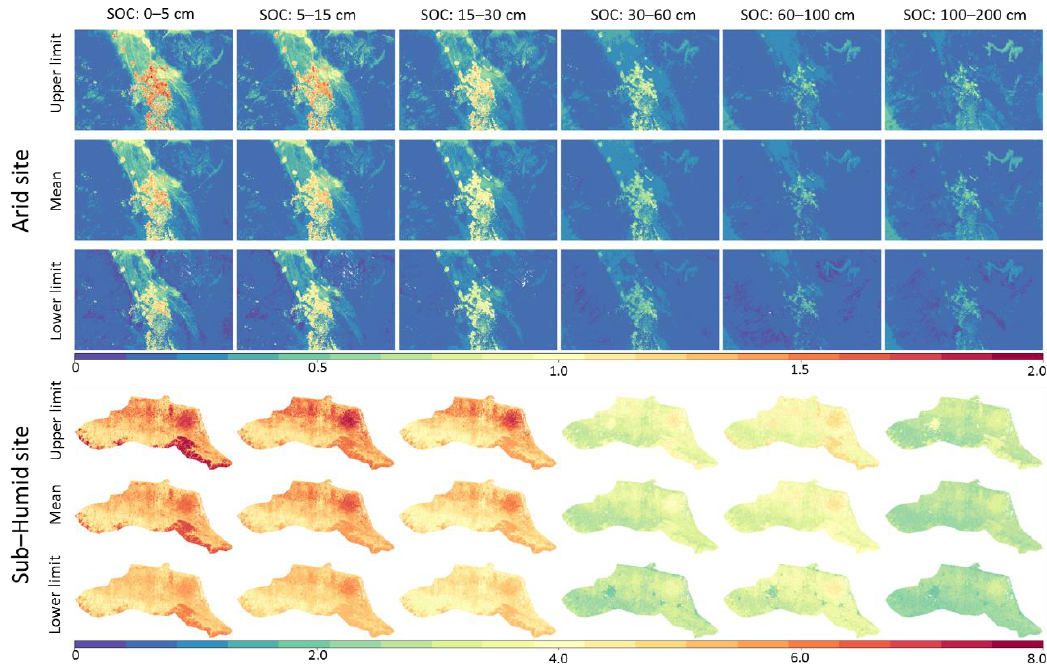
Figure 8. The spatial distribution of mean, upper, and lower limits of SOC contents at six standard depths in two regions. The upper and lower limits were calculated using Mean ± (1.5 × standard deviation (SD)) of the prediction values of SOC contents using the spatial block